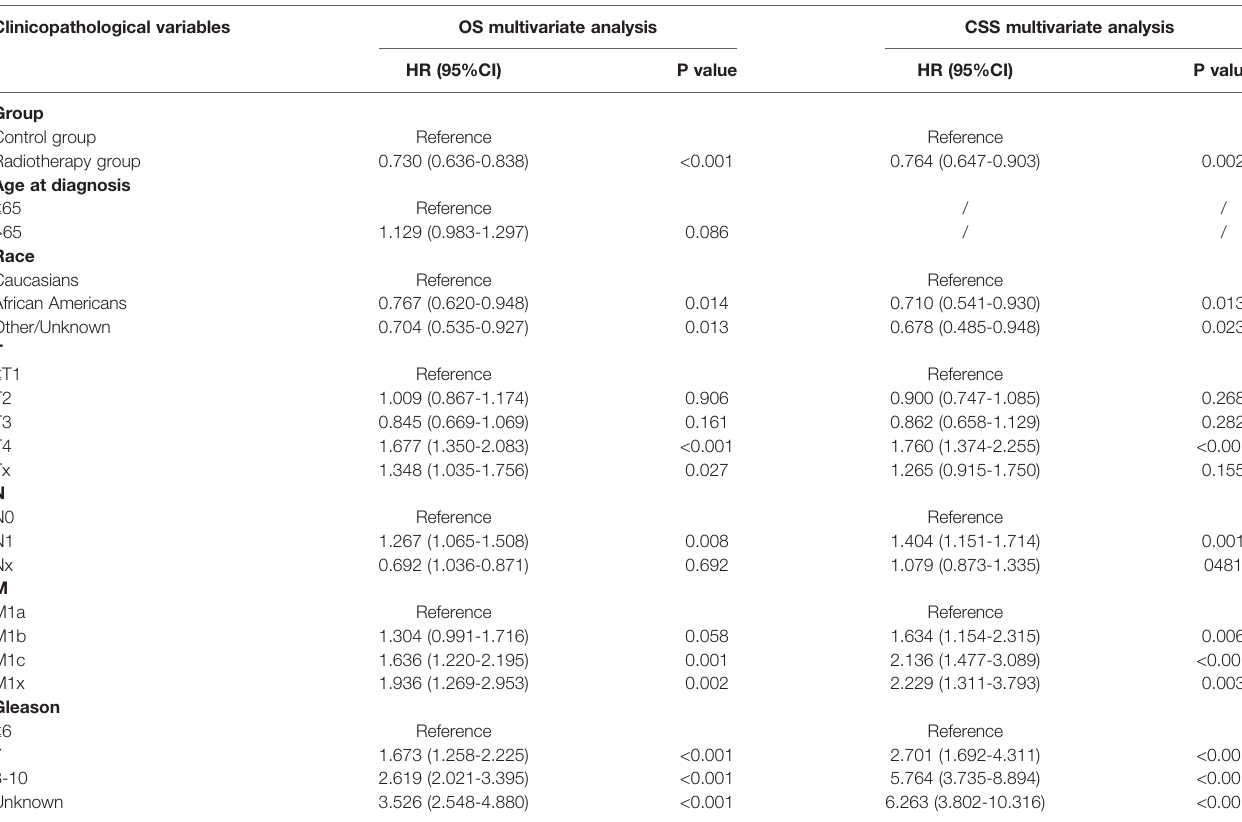
TABLE 2 | Multivariate Cox regression analysis of treatment groups in PSA 4.1-10ng/ml